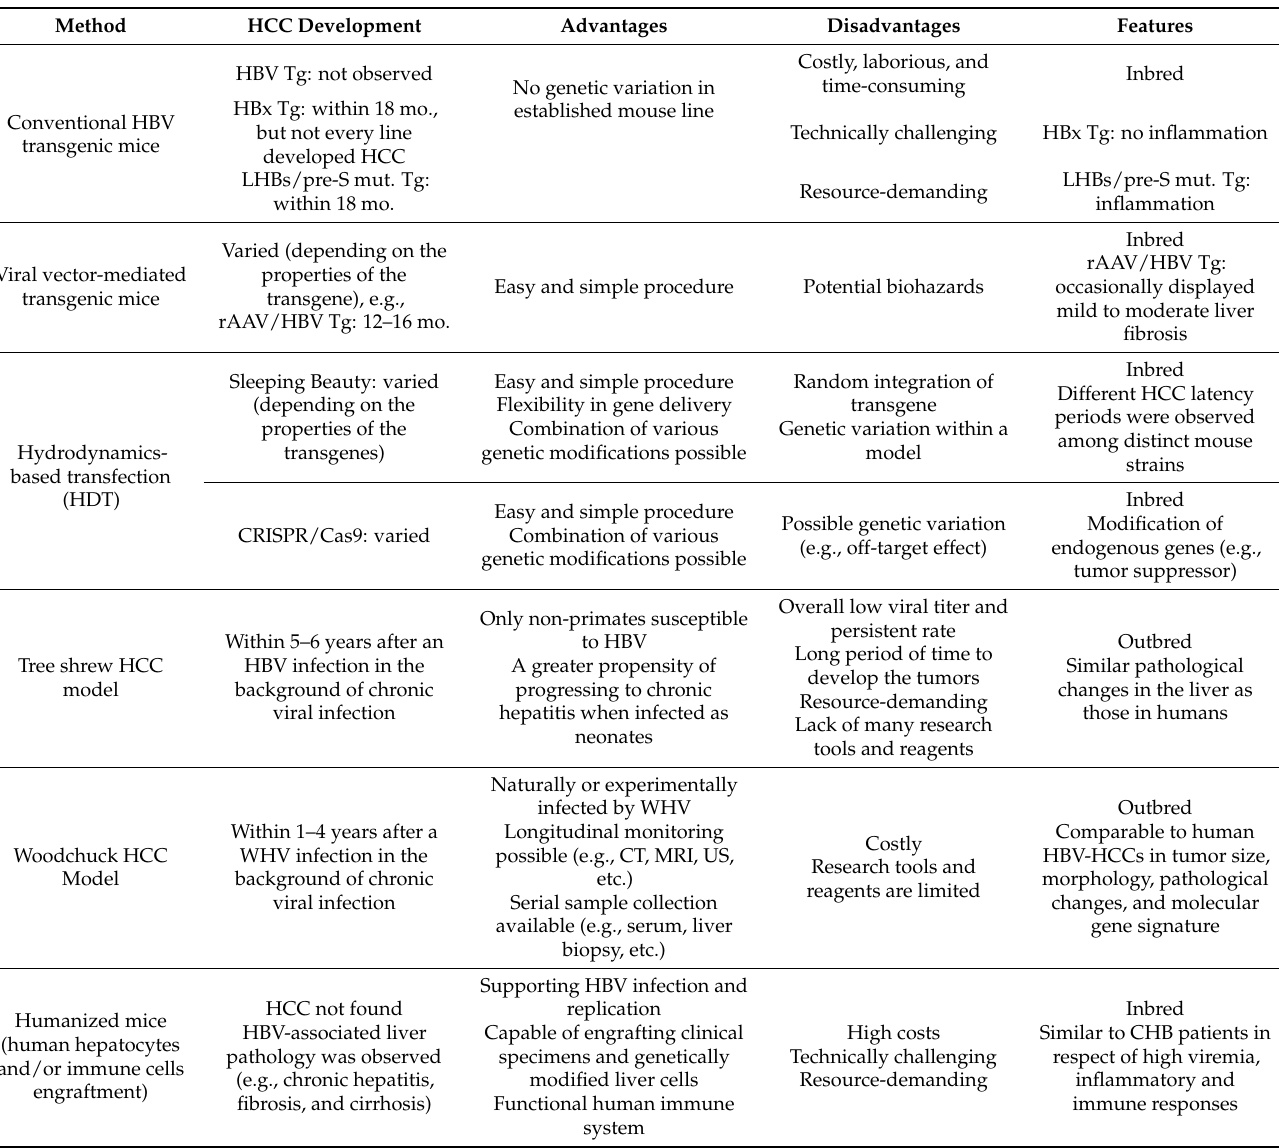
Table 1. Comparison of HBV-HCC Animal